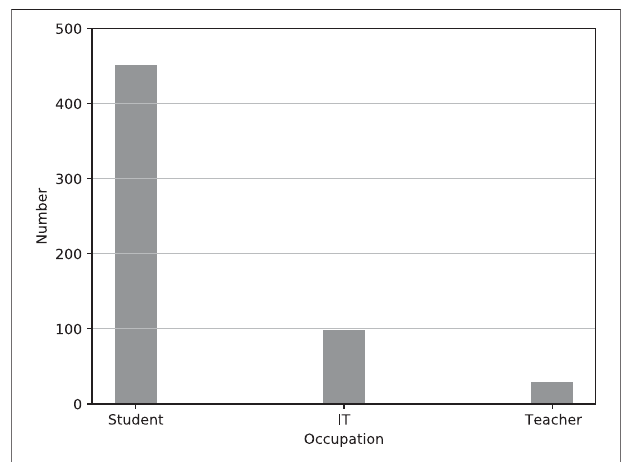
FIGURE 6 | Occupation of Twitter users most positive towards the fi fth generation of cellular networks (5G).